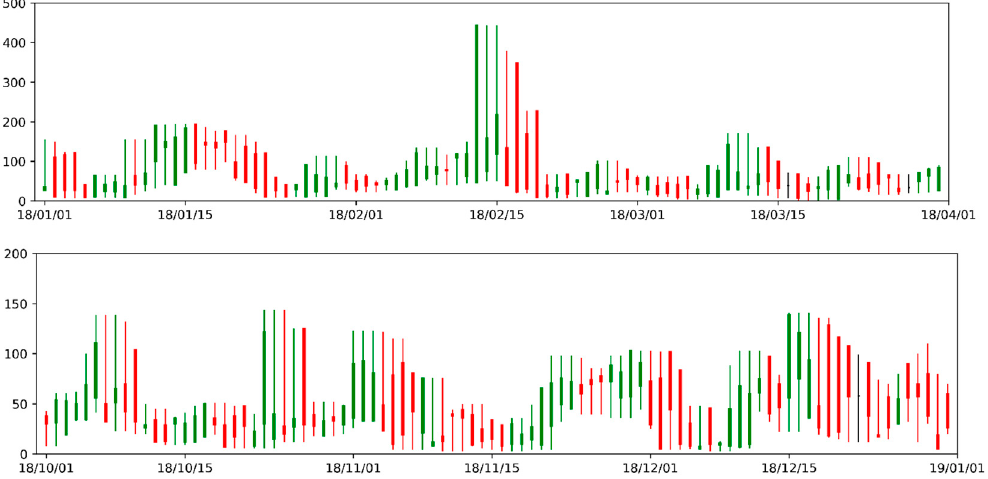
Figure 11. Candlestick chart of the PM 2.5 data in 2018. Figure 10. Candlestick chart of the PM 2.5 data in 2018. Figure 10. Candlestick chart of the PM 2.5 data in 2018.